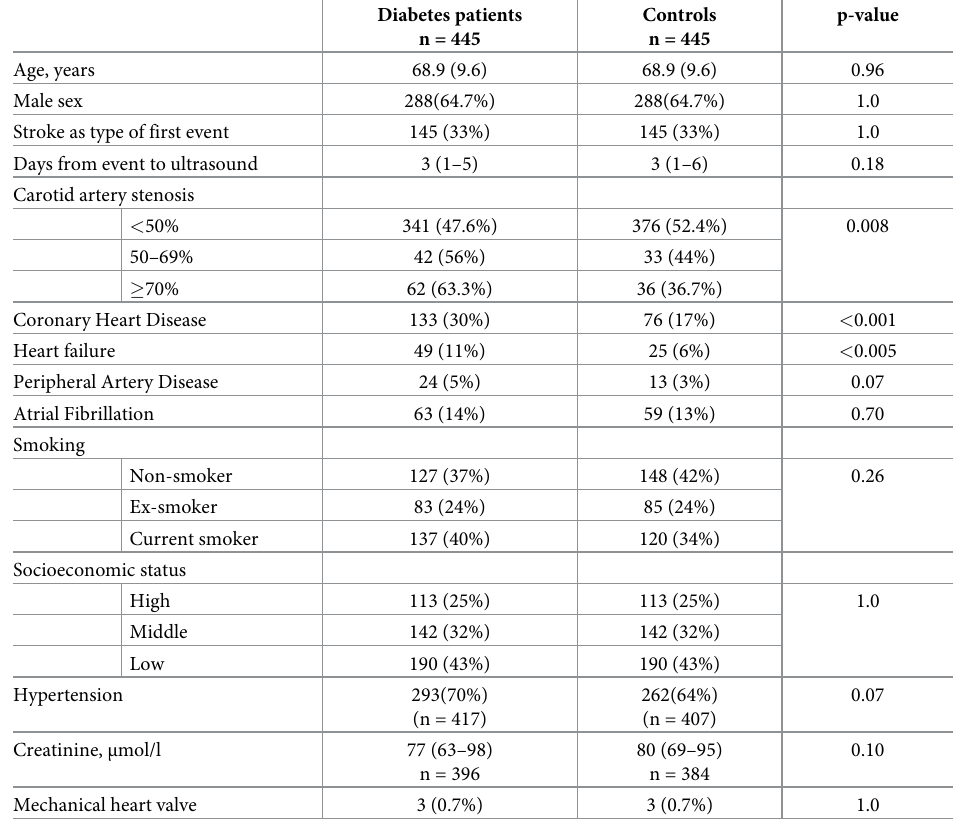
Table 1. Comparison of clinical characteristics between diabetes patients and